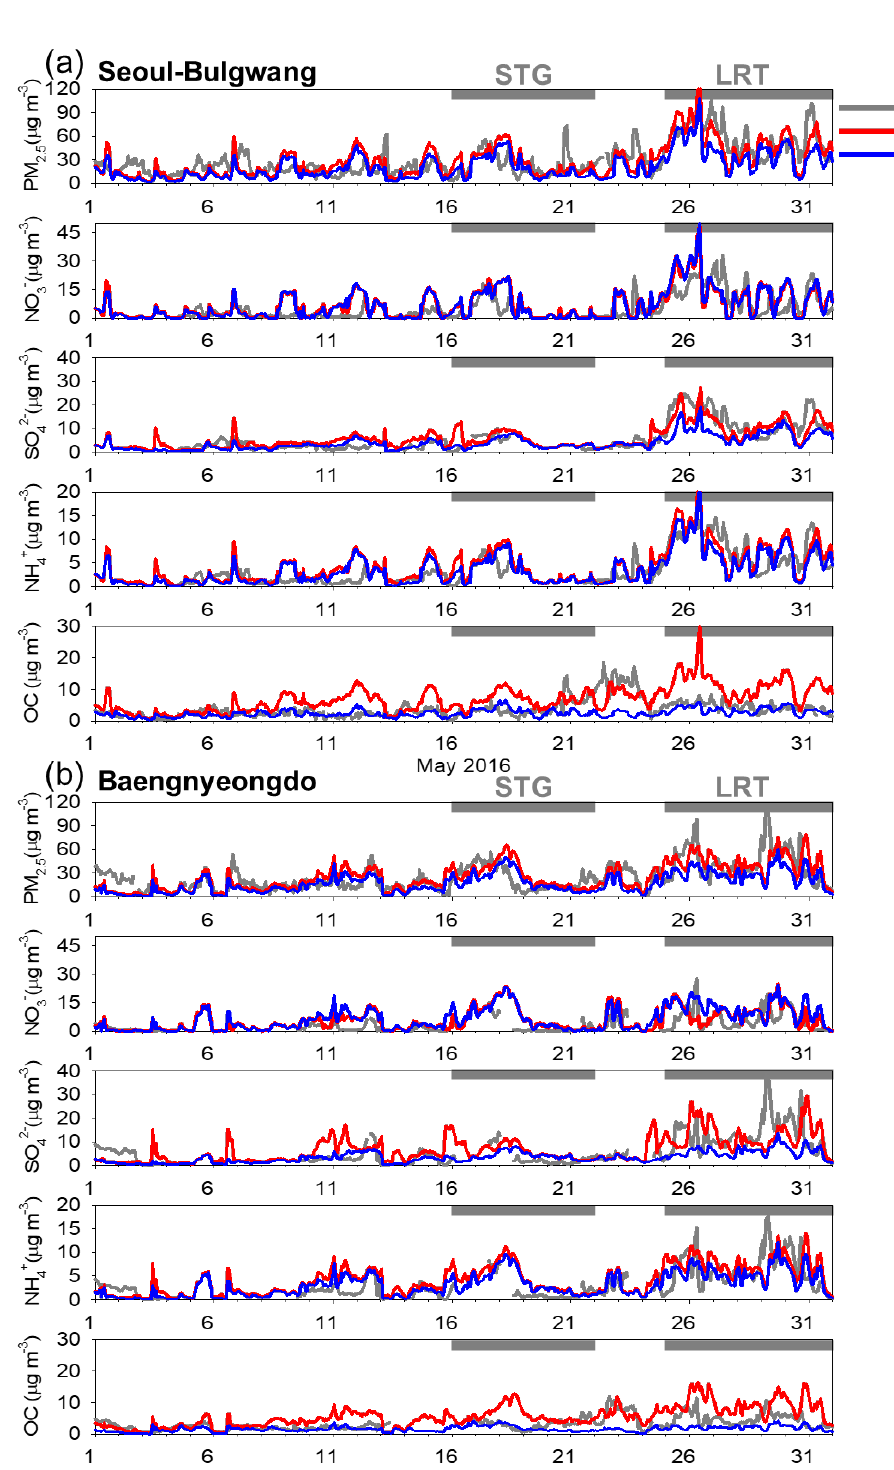
Figure 3. Time series of daily mean PM 2.5 mass, and its chemical components, SO 42− , NO 3− , NH 4+ , and OC concentrations observed in ( a ) Seoul-Bulgwang and ( b ) Baengnyeongdo sites for May 2016 including two periods, stagnant (STG) and long-range transport (LRT) periods. Modeling results from two modules: MADE/VBS (red) and MADE/SORGAM (blue) were also denoted.